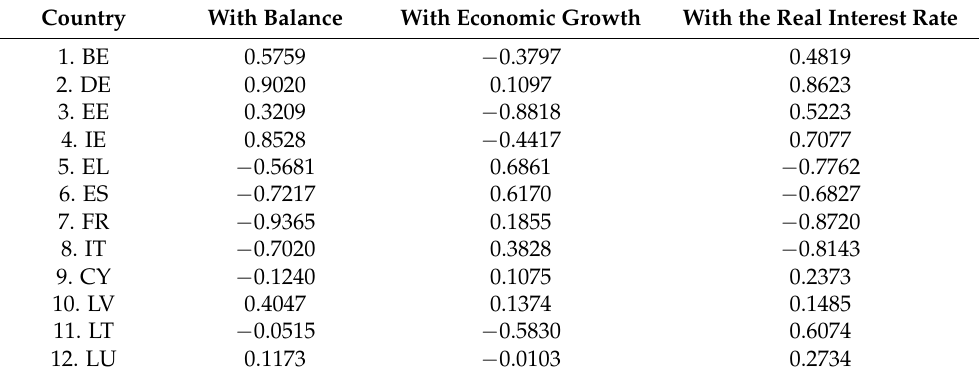
Table 1. Correlation values between government debt and independent variables in euro area member states,